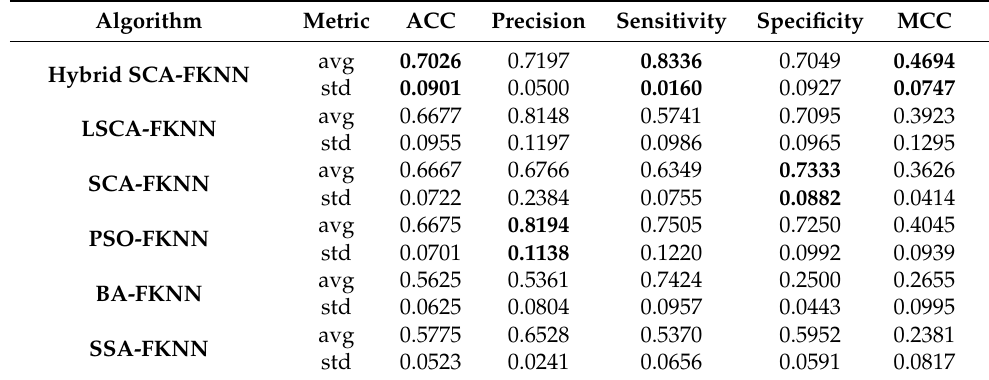
Table 8. Results of the hybrid-FKNN and comparison models on the caesarian section classification dataset. (Bold indicates the best in comparison